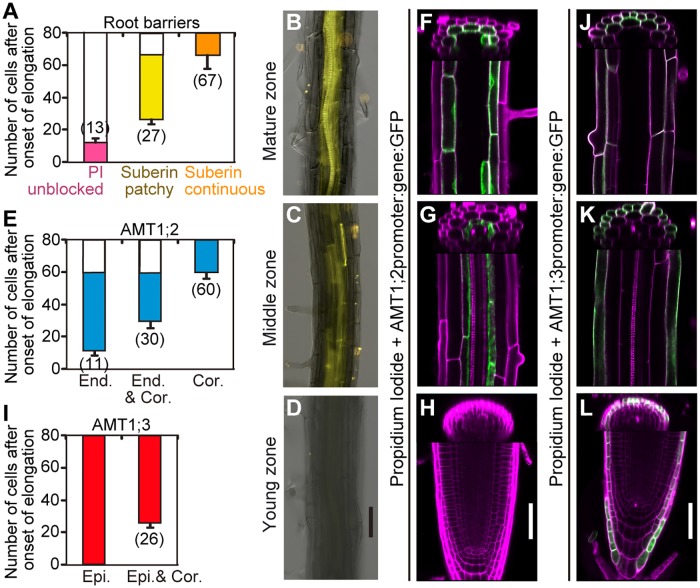
Longitudinal distribution of AMTs and apoplastic diffusion barriers along the root axis.(A) Establishment of functional CSs (PI unblocked), patchy suberin, and continuous suberin along the root axis. CS formation started from the 13th elongated cell onward, indicating that the root zone below the 13th elongated cell down to the initiation of xylem cells represents an endodermal bypass even in WT plants. A zone of patchy suberization extended from the 27th elongated cell up to the 67th cell, from which onward suberin deposition became continuous. (B–D) Fluorol yellow staining shows the presence of suberin in endodermal cells of mature (B), middle (C), and young (D) apical root zones. (E–H) Quantitative assessment (E) and confocal images of root tissue expressing proAMT1;2:AMT1;2:GFP in mature (F), middle (G), and young root zones (H). (I–L) Quantitative assessment (I) and confocal images of root tissue expressing proAMT1;3:AMT1;3:GFP in mature (J), middle (K), and young root zones (L). Roots were stained with PI (magenta). Blockage of PI penetration into the apoplastic space of the stele shows the presence of functional CSs. Overlay of PI and GFP gives white signal. Scale bars in D, H, and L represent 50 μm. In B–D, F–H, and J–L, representative images of >15 plants are shown. In A, E, and I, the data represent means ± SD (n ≥ 15 roots). Numbers in brackets are mean values. “Onset of elongation” is defined as the point at which length of an endodermal cell was more than twice its width. Underlying data can be found in S1 Data. AMT, ammonium transporter; Cor., cortex; CS, Casparian strip; End., endodermis; Epi., epidermis; GFP, green fluorescent protein; PI, propidium iodide; WT, wild-type.